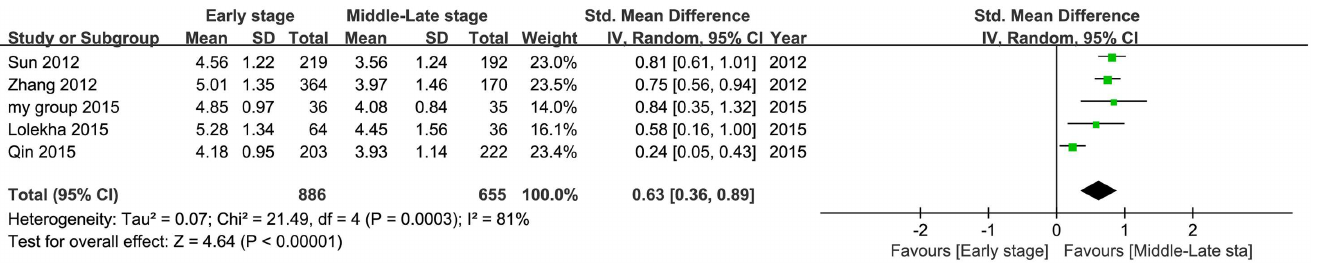
Fig 5. Forest plot of serum uric acid levels in early stage compared to middle-late stage